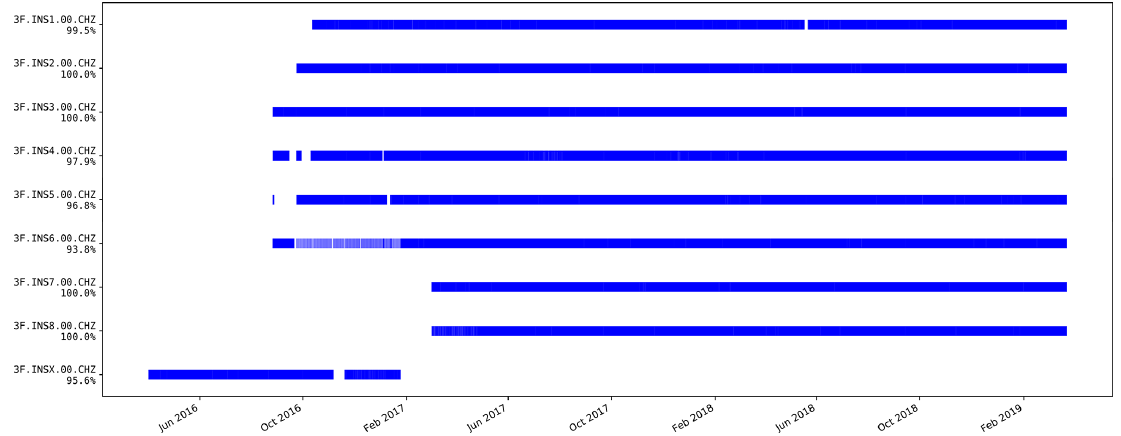
Figure 4. Data availability (blue lines) for all stations for the entire period of operation of the INSIEME seismic network. The analysis has been performed on the vertical component data stream of each station (CHZ channels). The percentage of data availability is reported below each station name.